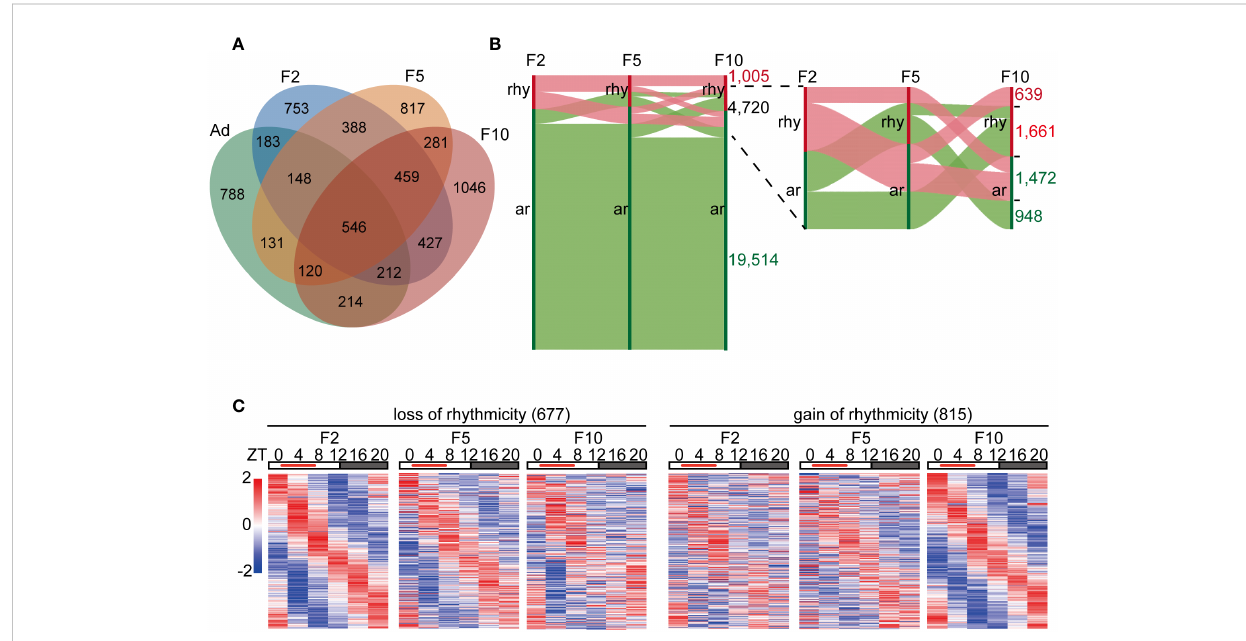
FIGURE 2 Liver diurnal rhythms are reprogrammed via multigenerational DRF. (A) Venn diagram displaying the total number of rhythmic genes in the liver from ad libitum , F2, F5 and F10, including common genes. (B) Changes in gene expression rhythms from F2 to F10. Vertical red bars represent rhythmic genes(rhy), while green bars represent arrhythmic genes(ar). Horizontal red bands represent changes in rhythmic genes, while green bands represent changes in arrhythmic genes in F2. (C) Left: heatmaps display generational rhythm-loss genes satisfying the following condition: meta2d_ P <0.05 in F2, meta2d_ P >0.05 in F10, and meta2d_ P in F5 is between meta2d_ P in F2 and F10. Right: heatmaps display generationally rhythm-gain genes satisfying the following condition: meta2d_ P >0.05 in F2, meta2d_ P <0.05 in F10, and meta2d_ P in F5 is between meta2d_ P in F2 and